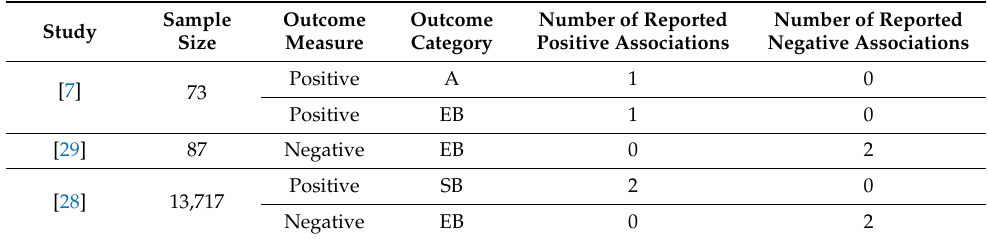
Table 2. Creative play—outcome measure descriptions and results summary.